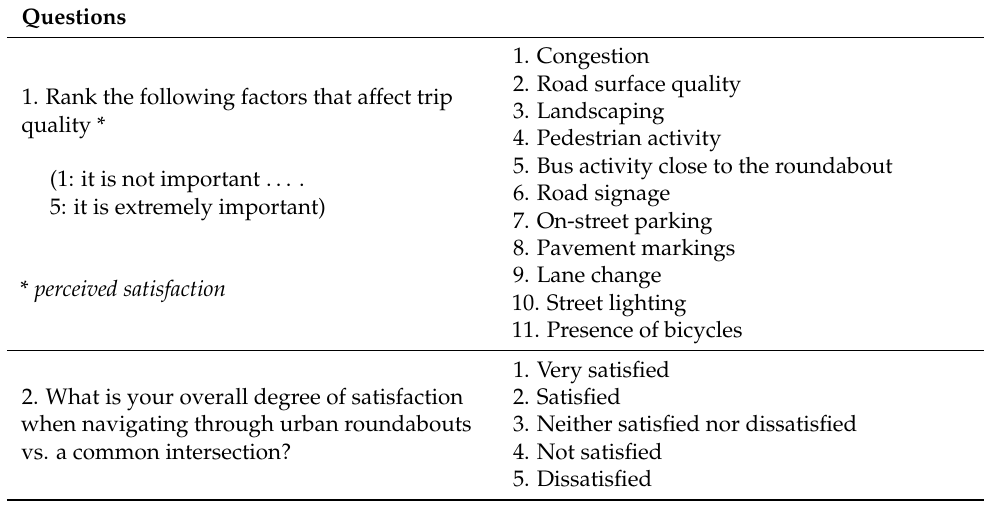
Table 1. Questions referring to the QOS of urban